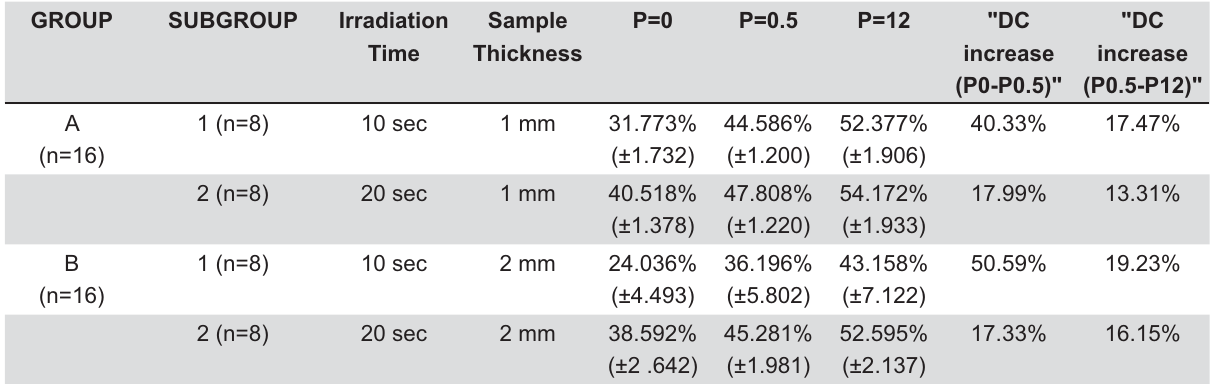
Table 1- (cid:8)(cid:11)(cid:12)(cid:13)(cid:3)(cid:8)(cid:14)(cid:15)(cid:8)(cid:2)(cid:16)(cid:8)(cid:17)(cid:18)(cid:13)(cid:3)(cid:19)(cid:13)(cid:20)(cid:19)(cid:8)(cid:19)(cid:12)(cid:21)(cid:22)(cid:13)(cid:18)(cid:22)(cid:23)(cid:3)(cid:7)(cid:8)(cid:23)(cid:24)(cid:18)(cid:13)(cid:22)(cid:3)(cid:12)(cid:19)(cid:8)(cid:22)(cid:3)(cid:8)(cid:18)(cid:25)(cid:12)(cid:8)(cid:19)(cid:22)(cid:26)(cid:26)(cid:12)(cid:20)(cid:12)(cid:3)(cid:18)(cid:8)(cid:27)(cid:20)(cid:23)(cid:28)(cid:29)(cid:17)(cid:8)(cid:23)(cid:26)(cid:8)(cid:30)(cid:4)(cid:31)!(cid:8)(cid:30)(cid:4)(cid:31)"#(cid:8)(cid:13)(cid:3)(cid:19)(cid:8)(cid:30)(cid:4)(cid:5)(cid:10)!(cid:8)(cid:13)(cid:3)(cid:19)(cid:8)(cid:18)(cid:25)(cid:12)(cid:8)(cid:29)(cid:12)(cid:20)$(cid:12)(cid:3)(cid:18)(cid:13)(cid:27)(cid:12)(cid:8) increase of